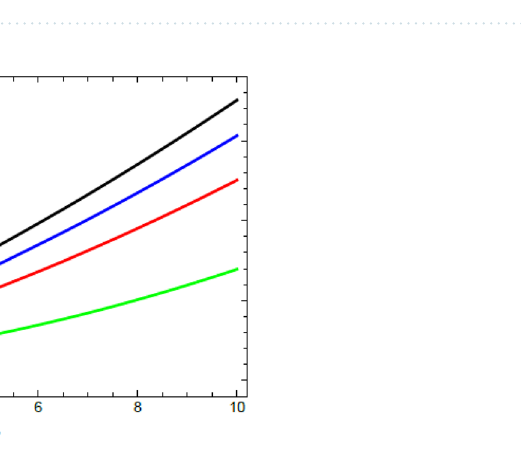
Figure 28. Nusselt number versus Pr as given in Eq. (37) to depict the effect of the Stefan blowing factor S w and Schmidt numeral S c .